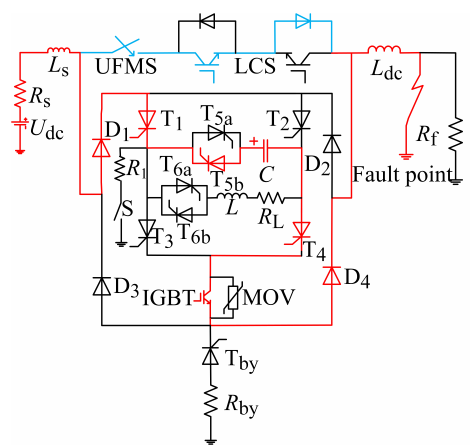
Fig. 3. Normal closing sequence diagram